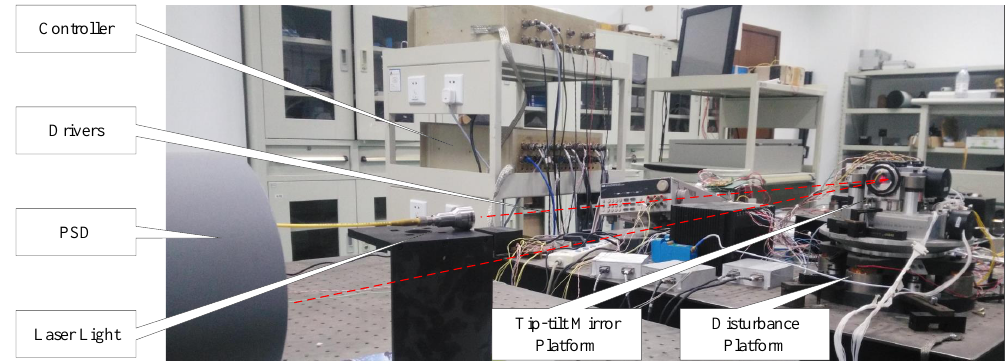
Figure 8. The experimental